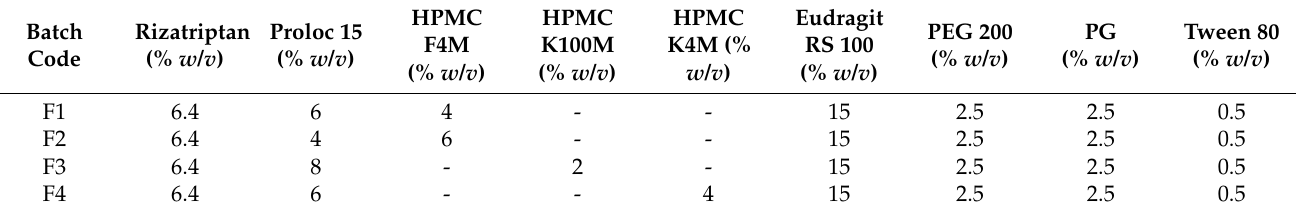
Table 2. Compositions used for preparing rizatriptan containing buccal